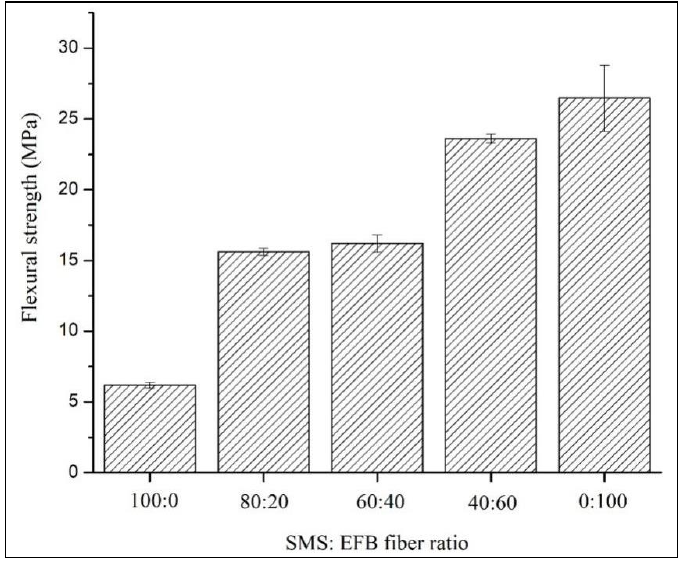
Figure 10. Effect of the fiber ratio of SMS and EFB fibers on the flexural strength of the sandwich composite panel.